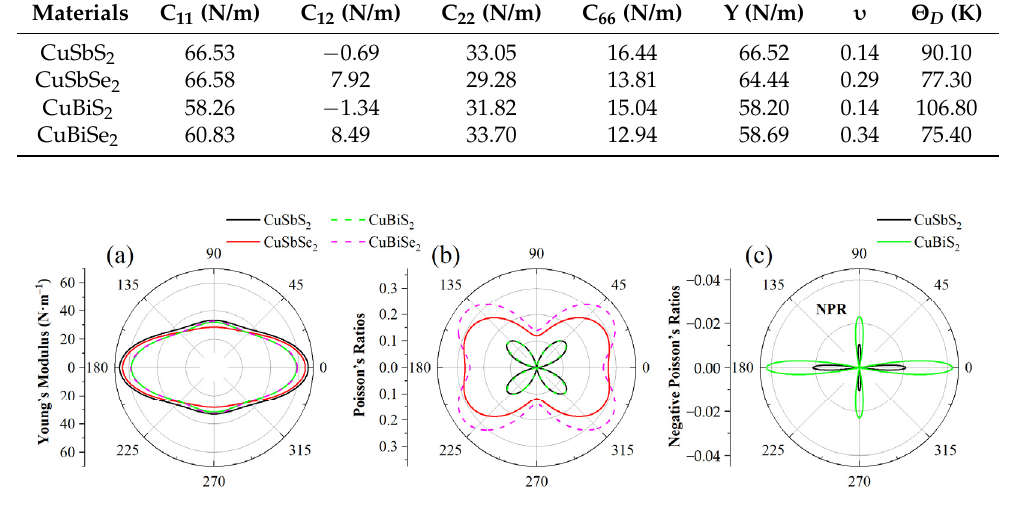
Figure 2. ( a ) The Young’s moduli: ( b ) Poisson’s ratio; and ( c ) NPR of 2D CuMN 2 (M = Sb, Bi; N = S,